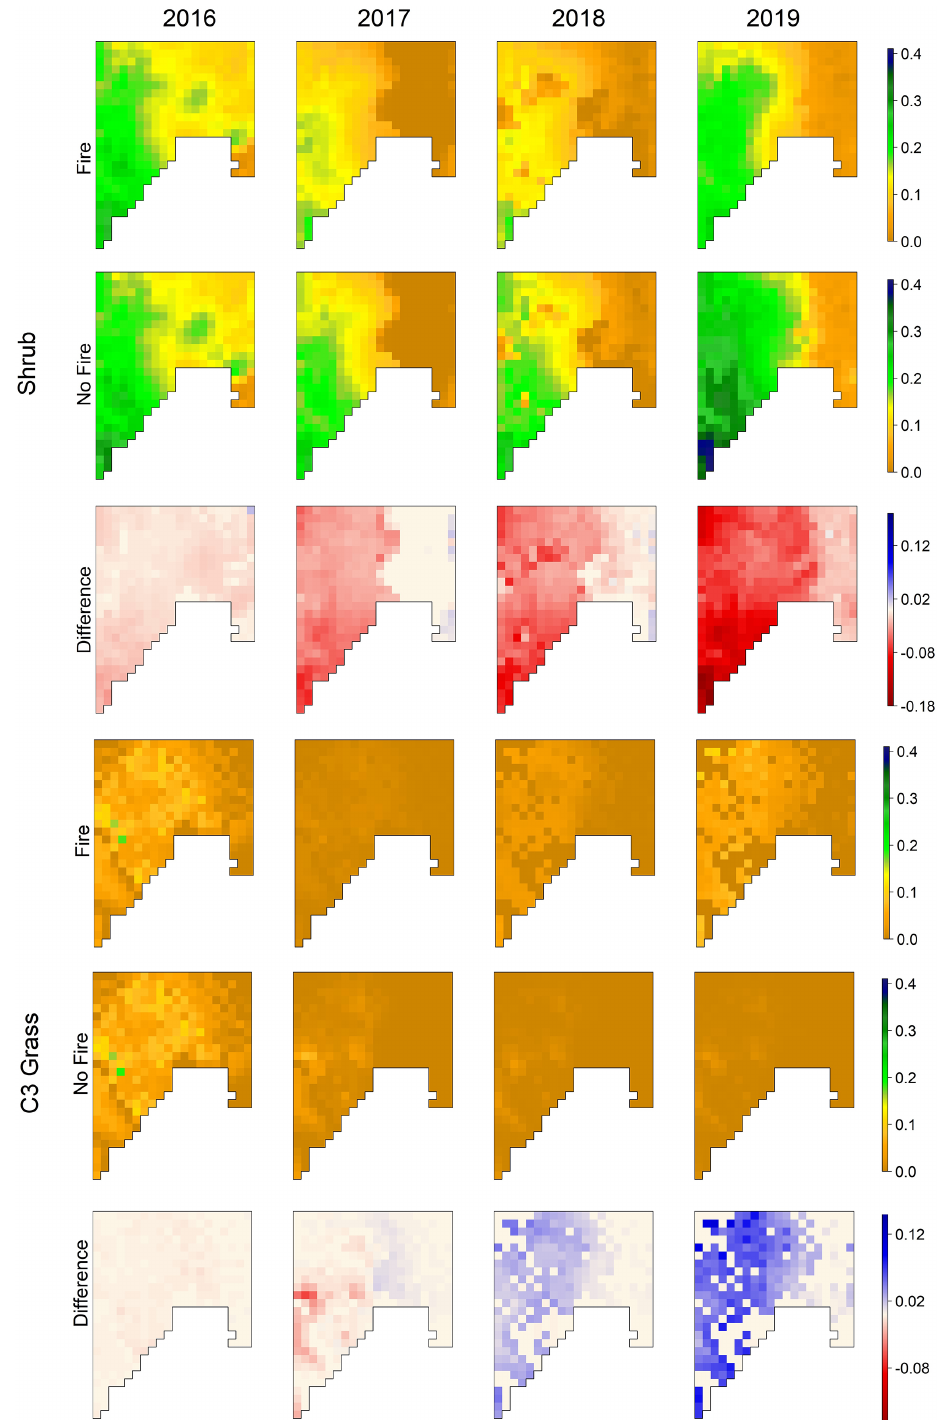
Figure A2. EDv2.2-predicted mean monthly GPP (kgCm − 2 yr − 1 ) for July for the Soda Fire scenario, separated for shrub and C 3 grass PFTs with fire and without fire, and the difference between the two scenarios for the years 2016 to 2019 (representing post-fire years after the Soda